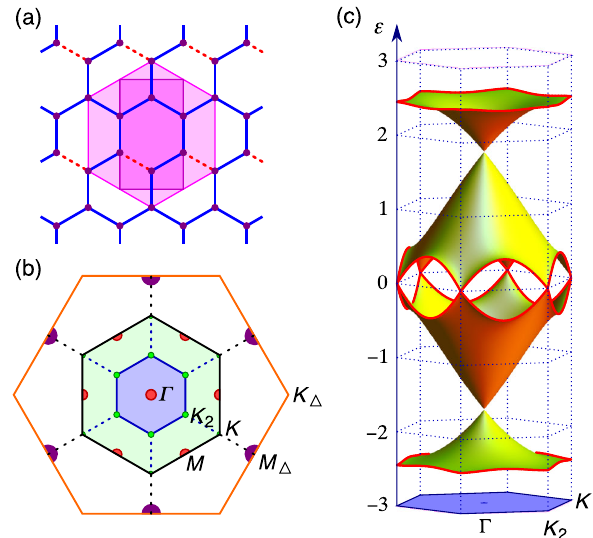
FIG. 5. Properties of the (cid:1) -flux state. (a) Sketch of the gauge used to implement the (cid:1) -flux state: the hopping amplitude is positive on solid blue bonds, negative on dashed red bonds. The primitive unit cell (dark magenta) contains four sites, the hexagonal unit cell eight sites. (b) Brillouin zones and high symmetry points. The red circles indicate the position of the ffiffiffi p 3 t to which the Fermi surface reduces at FIG. 6. The algebraic decay of the correlation along a zigzag Dirac nodes at " D ¼ (cid:5) quarter filling in the (cid:1) -flux state. The orange, outermost hexagon chain in the honeycomb lattice for the Gutzwiller projected (cid:1) -flux state in different clusters. (Every second site is shown; shows the extended Brillouin zone of the triangular lattice (cid:4) is the distance along the chain.) In the inset, we compare the (including sites at the centers of the hexagons in the honeycomb lattice), the structure factor is maximal and has a cusp at M 4 ¼ correlations of the same (cid:1) -flux state with the correlations of a ffiffiffi p 3 ð (cid:1); (cid:1)= Þ and the symmetry related points. K 300-site-long, one-dimensional chain. (We projected the one- ffiffiffi p 4 is given by 3 ð 4 (cid:1)= 3 ; 0 Þ , K is ð 2 (cid:1)= 3 ; 2 (cid:1)= 3 Þ . (c) The two-fold degenerate dimensional quarter-filled Fermi sea.) While the periodicity of band structure of the (cid:1) -flux state in the reduced Brillouin zone four is visible in both cases, the correlations decay much faster in of an 8-site hexagonal unit cell. the two-dimensional honeycomb